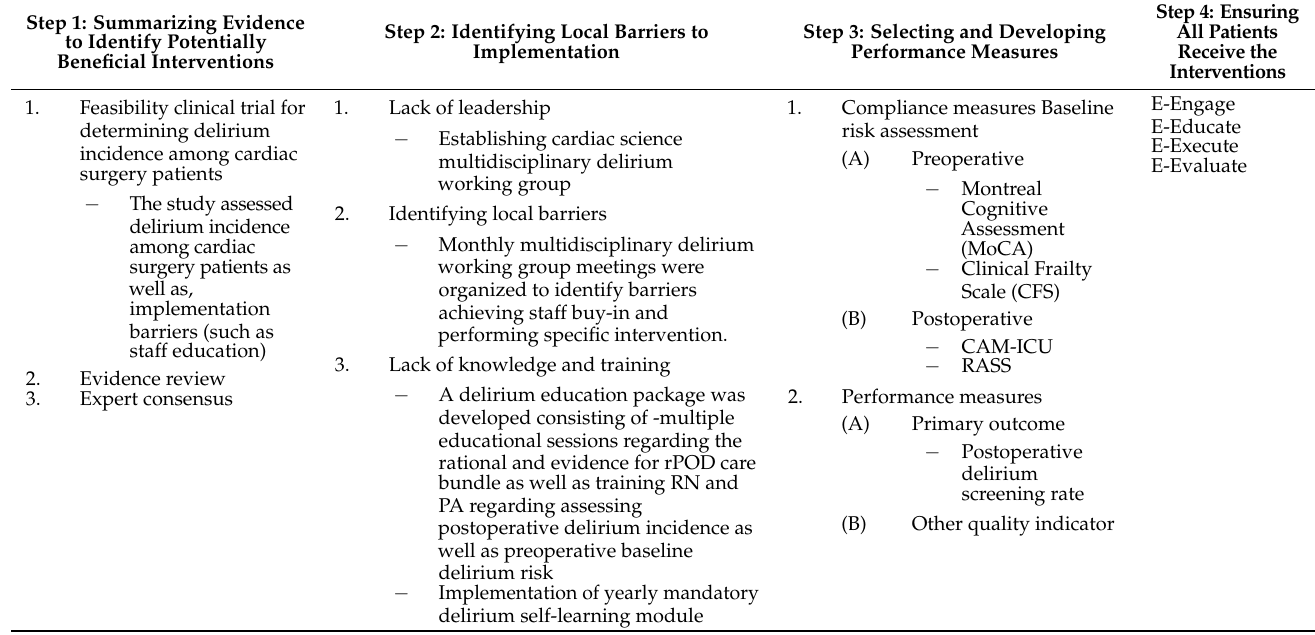
Table 1. Quality improvement